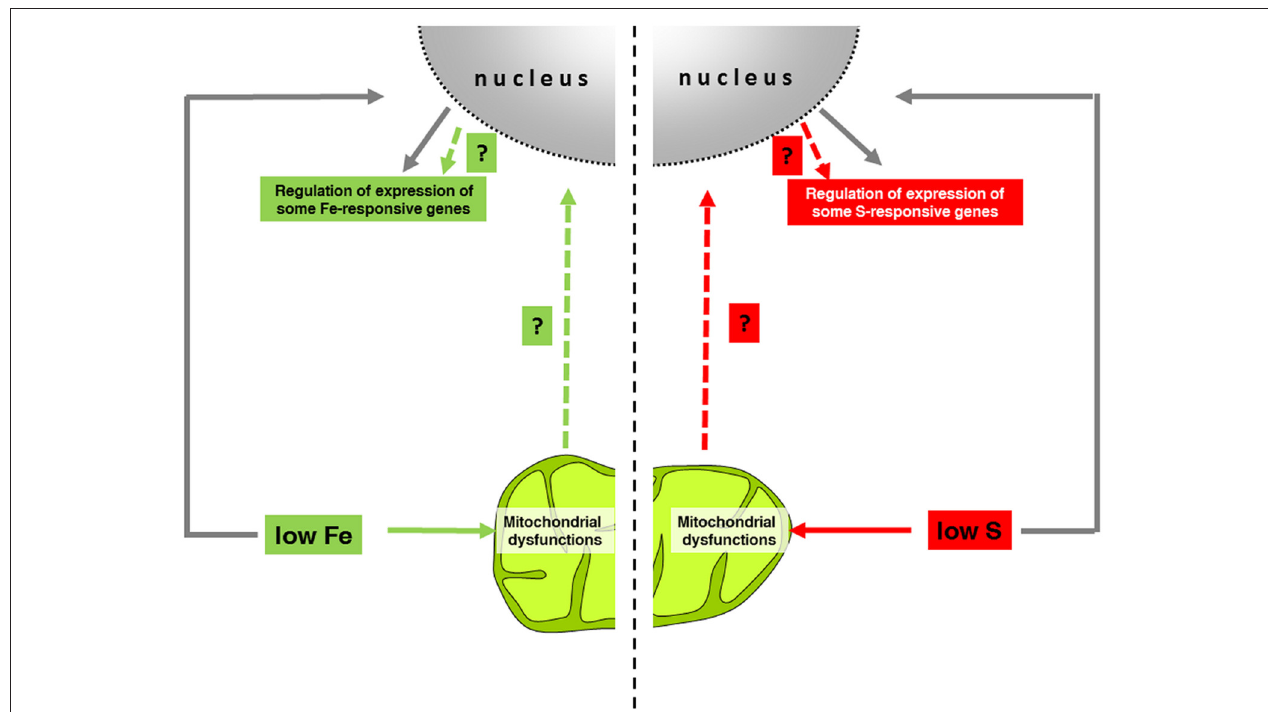
FIGURE 1 | Schematized model of the possible role of mitochondria in the regulation of nutrient-responsive genes. As Fe and S are essential elements for Fe–S cluster-containing proteins, deficiencies of such nutrients trigger mitochondrial dysfunctions mainly at the respiratory chain level. Through the comparison of different data sets (mitochondrial dysfunctions vs. Fe- and/or S-responsive genes), nutrient-responsive genes have been identified as potential candidates of hypothetical retrograde signaling pathways (PYE, BTS, FRO3; OPT3, SAM1 for Fe homeostasis and SULTR1;2 SULTR3;4, SULTR4;2, LSU1, BGLU28, SDI1 for S homeostasis). Mitochondrial impairments occur in long term of Fe and S starvations; therefore, such retrograde signaling would occur in a second phase of the regulation of nuclear gene expression, whereas the first phase (gray arrows) involved a more direct nutrient-sensing